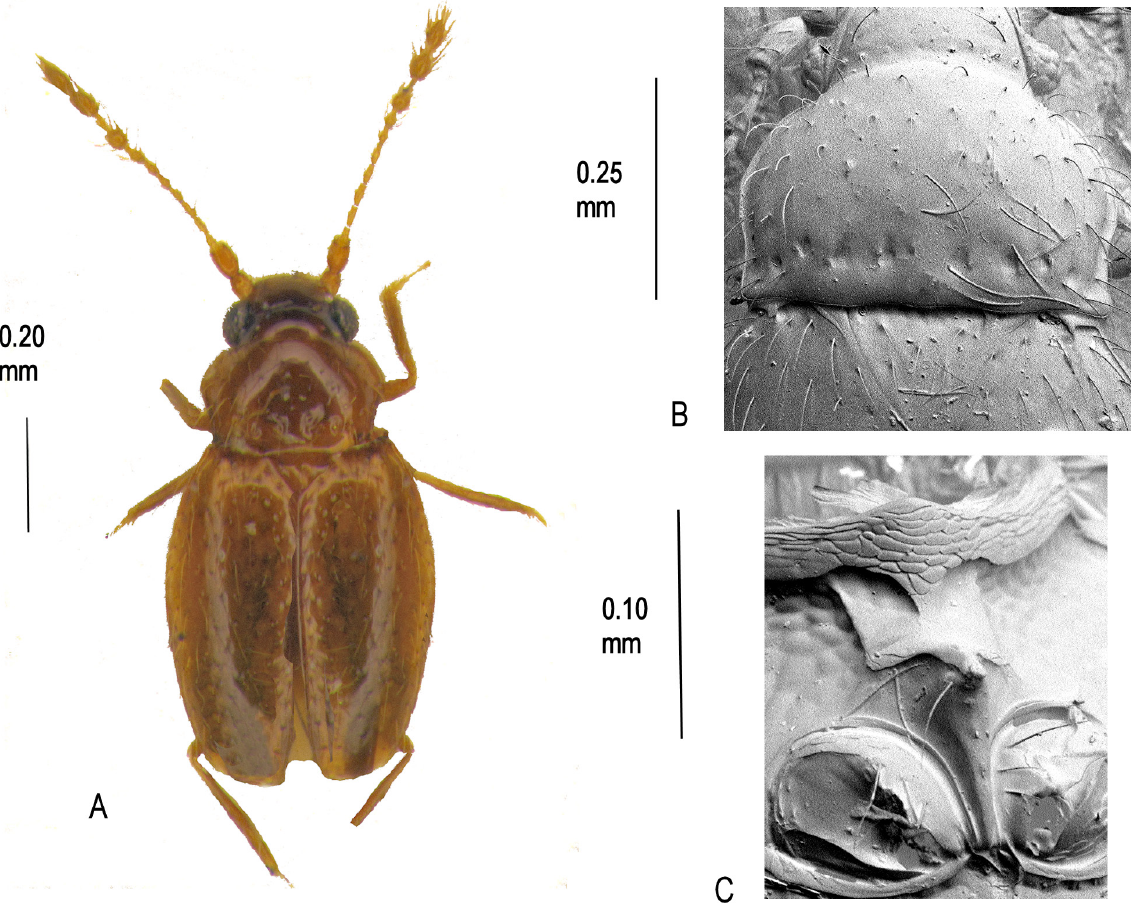
Fig. 42 . Cissidium rogeri sp. nov. A . Habitus. B . Pronotum, × 610. C . Mesoventrite showing median process of collar, mid-keel and keel,